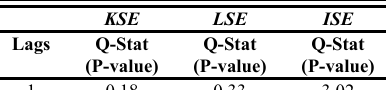
Table 4: LB-Q statistics KSE LSE ISE Lags Q-Stat Q-Stat Q-Stat (P-value) (P-value)